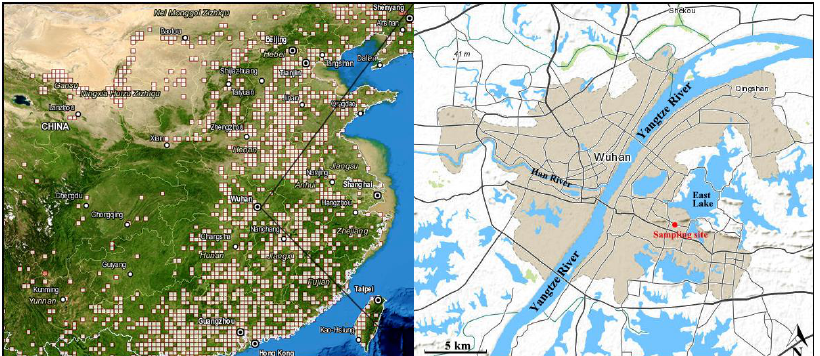
Figure 1. Geographic location of the sampling site. White blocks in left panel represent total distribution of wildfires in autumn 2014, and urban area in Wuhan is highlighted in gray in the right